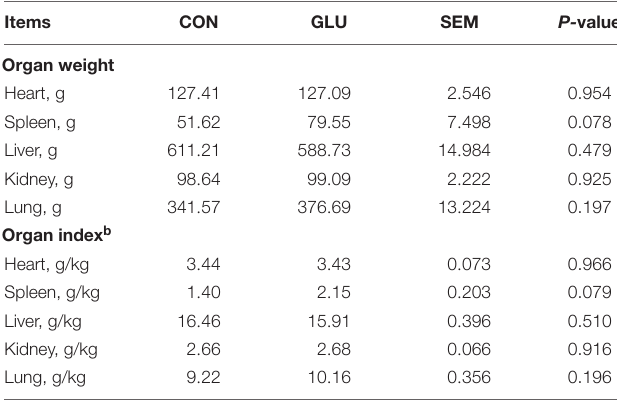
TABLE 5 | Effects of glutamate supplementation on apparent nutrient digestibility of heat-stressed Hu sheep ( n = 6) 1 . Items